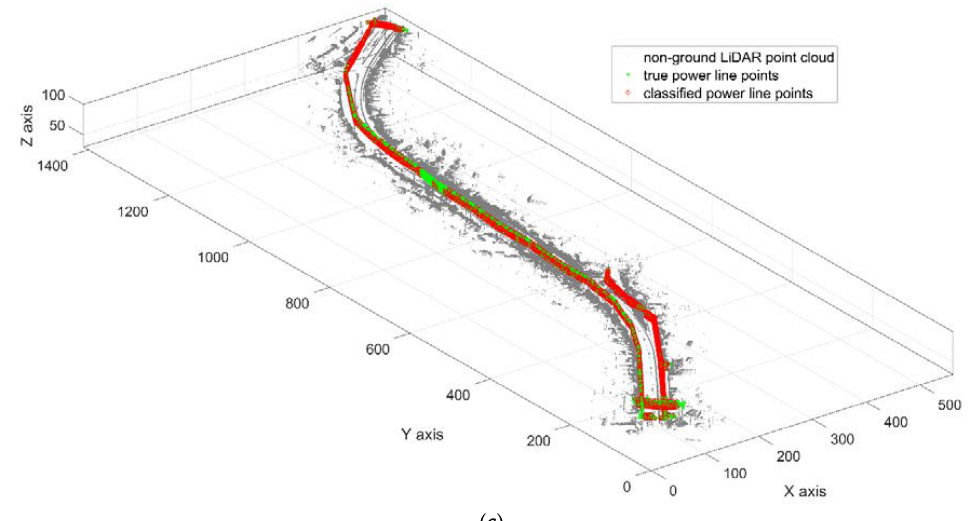
Figure 3. Visualization of the experiment results of power line classification for the five light detection and ranging (LiDAR) data sites, which involve the non-ground LiDAR point cloud, true power line points, and classified power line points. ( a ) is the power line classification result of data site II, which is a complex urban scene and ALS point cloud; ( b ) is the power line classification result of data site III, which is a forest scene and ALS point cloud; and ( c ) is the power line classification result of data site V, which is a suburban scene and MLS point cloud.